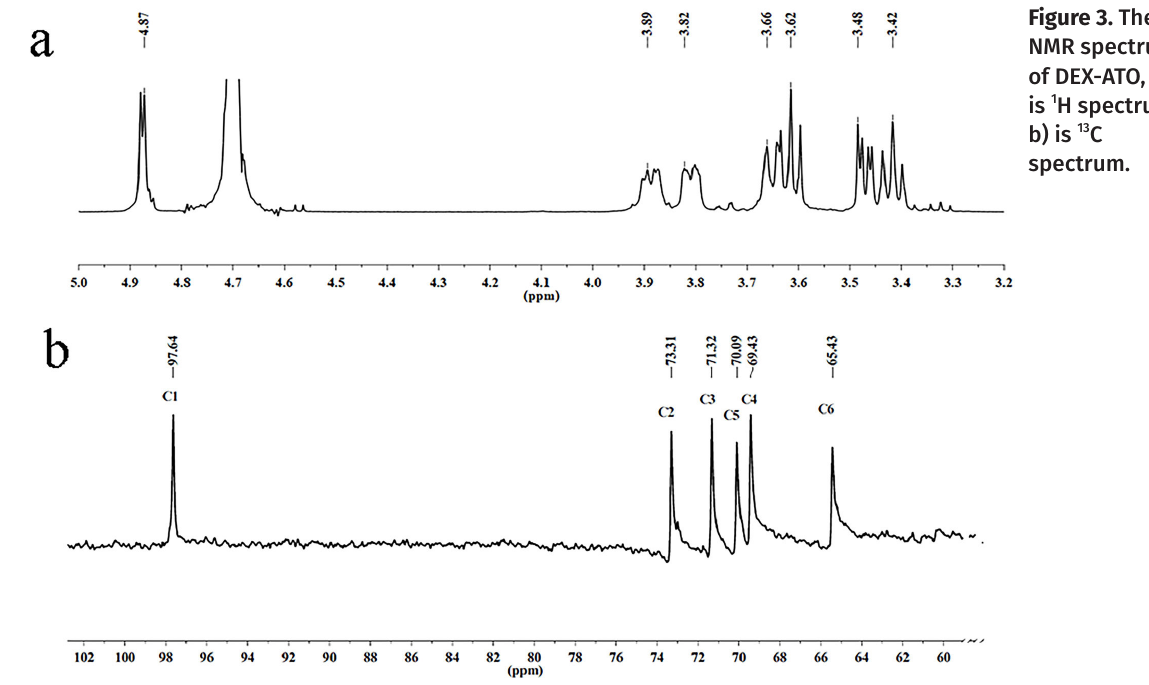
Figure 3. The NMR spectrum of DEX-ATO, a) is 1 H spectrum, b) is 13 C